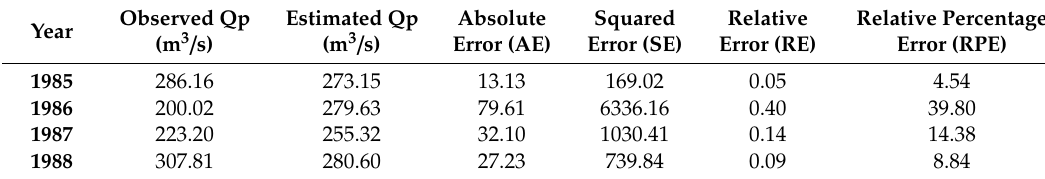
Table 3. Comparison of error functions for annual peak flows for the Imo River outlet between 1985 and 1988.